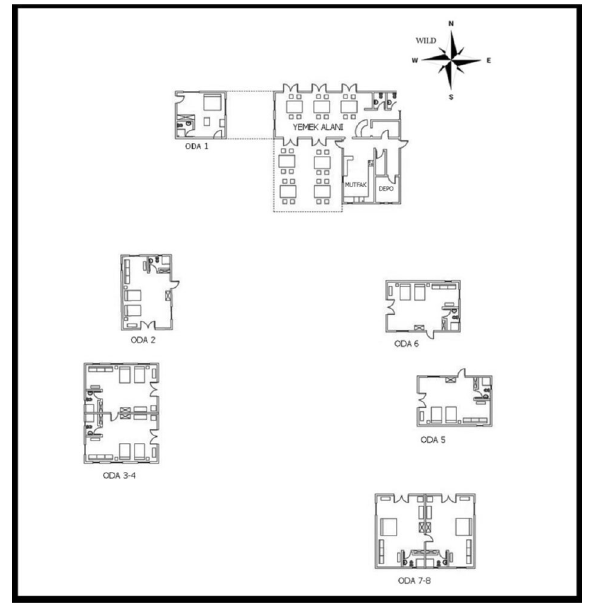
Fig. 12 Villa Lembos Hotel. Plan sketch — Risokarpaso.